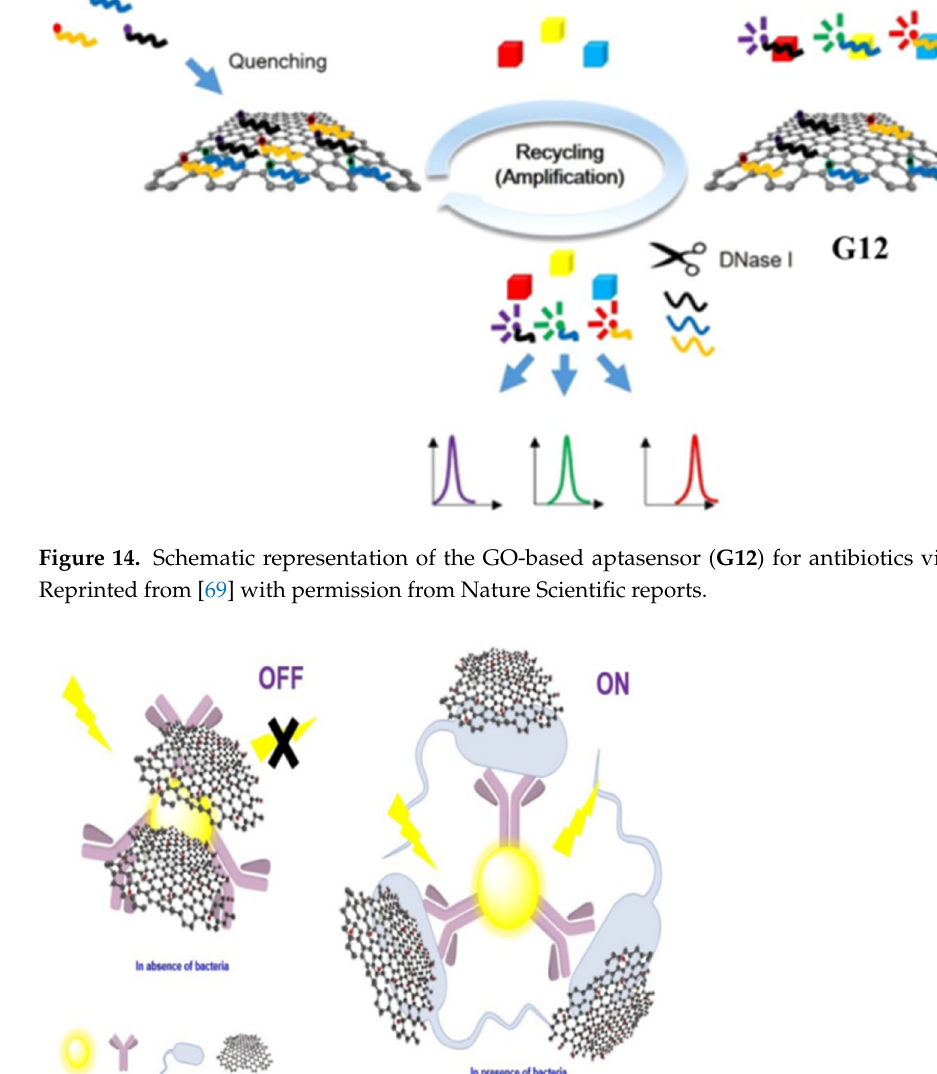
Figure 16. Schematic representation of the rGQDs-aptamer ( G14 ) preparation and DX sensing. Re- printed from [71] with permission from Elsevier. Ghourchian and co-workers [72] synthesized a GQD-based fluorescent probe G15 for the selective detection of Vi antigens. The probe iron porphyrin bio-mimicking Fe-N- GQDs were prepared using a solvothermal approach through mechanochemical mixing of Fe, N, and C sources. The prepared G15 could act as an energy donor because of π – π stacking, and GO could act as a quencher (Figure 17). As a result of the specific antibody– antigen interaction in G15 in the presence of the Vi antigen, the distance between the probe and GO was increased, which hindered the FRET process. When an antibody was